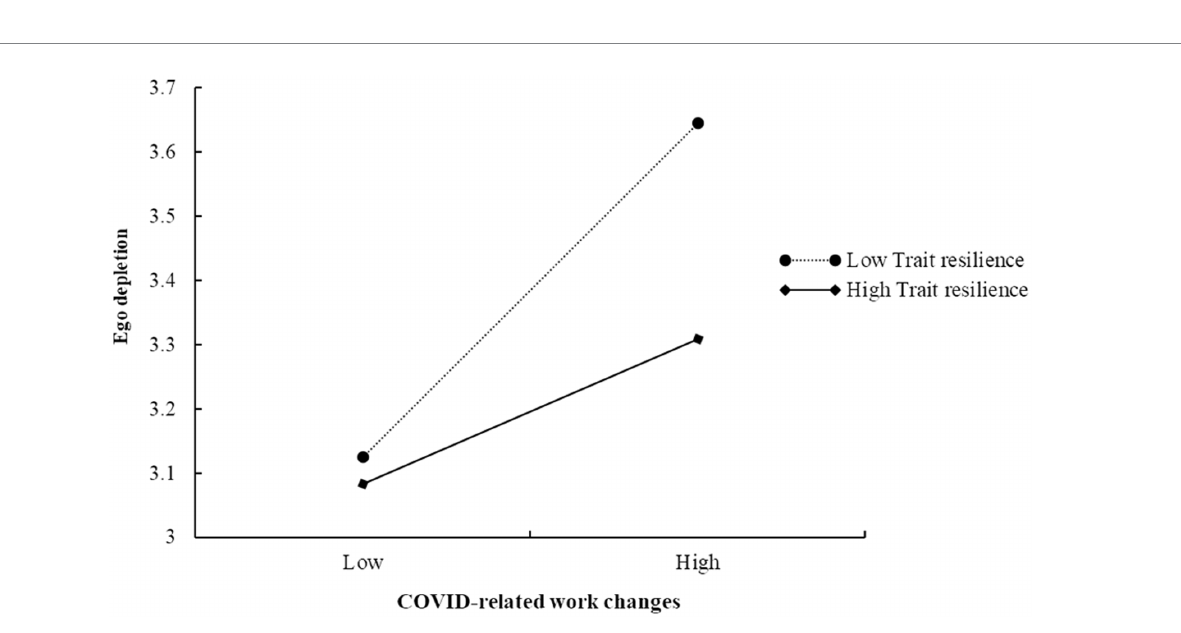
FIGURE 2 The moderating effect of trait resilience on the relationship between COVID-related work changes and ego depletion.